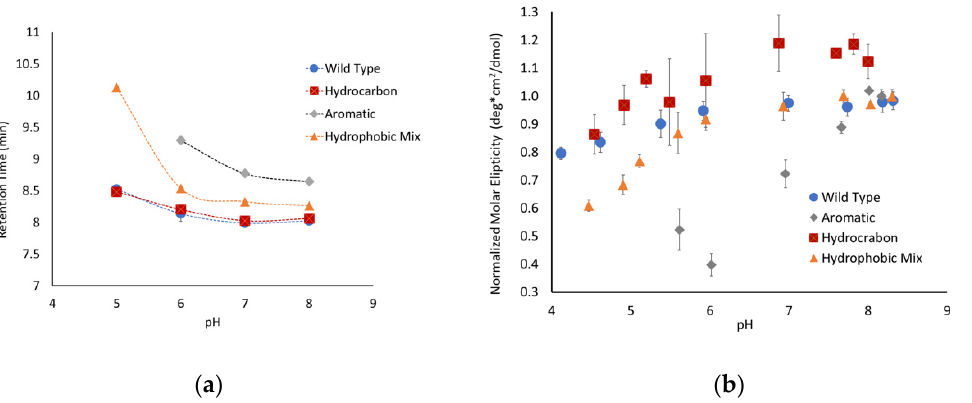
Figure 4. Conformational changes in peptides with hydrophobic linkers observed using ( a ) size- exclusion chromatography and ( b ) circular dichroism. Circular dichroism values at 200 nm were taken and normalized to the highest pH point for the peptide.